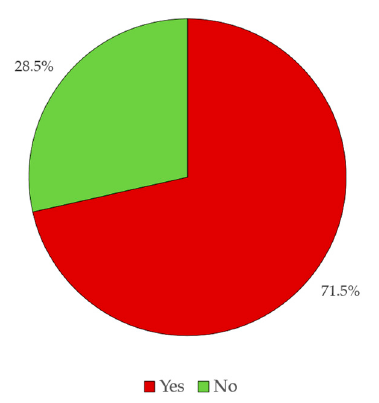
Figure 7. Results obtained in Step 1.